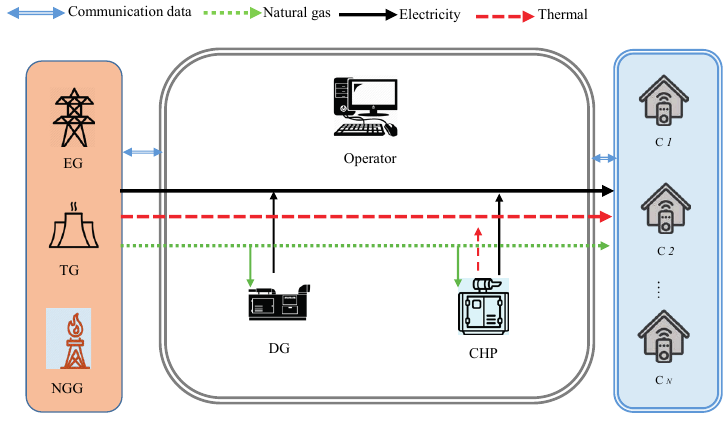
Fig.1. smart energy hub